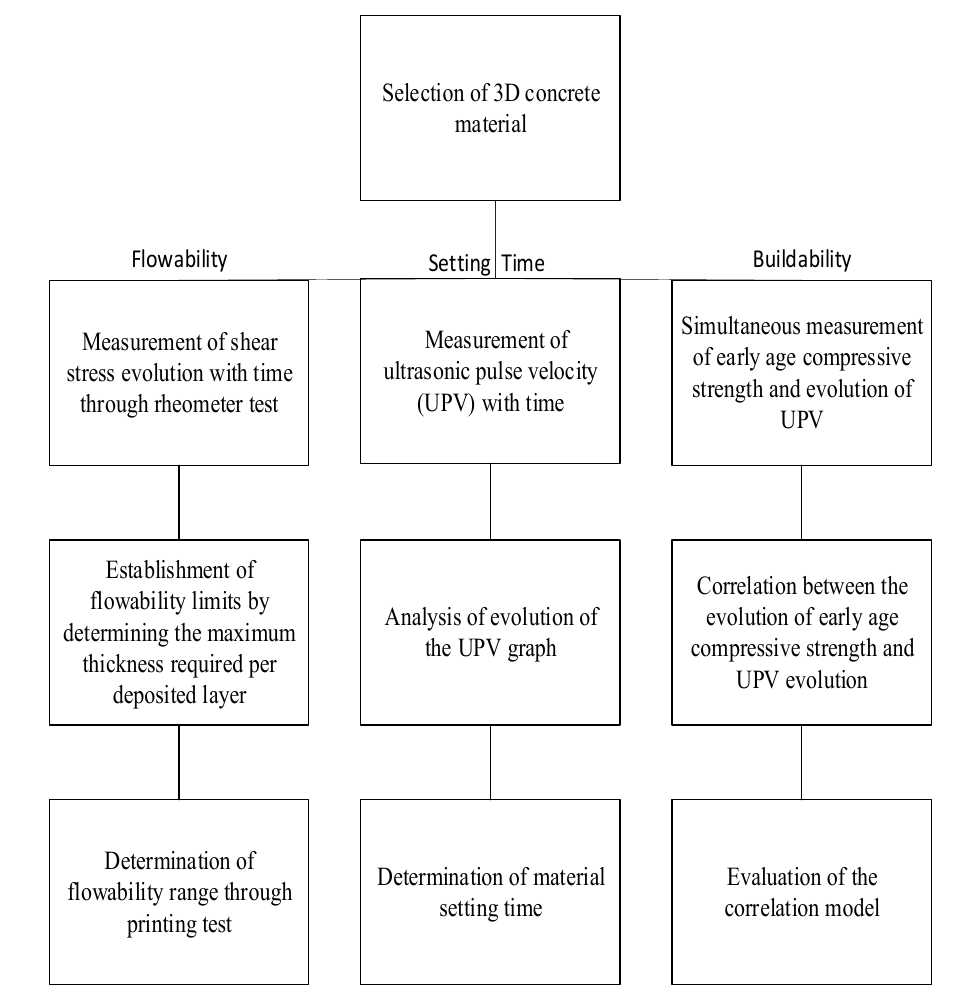
Figure 1. Workflow diagram of the process followed in this study.